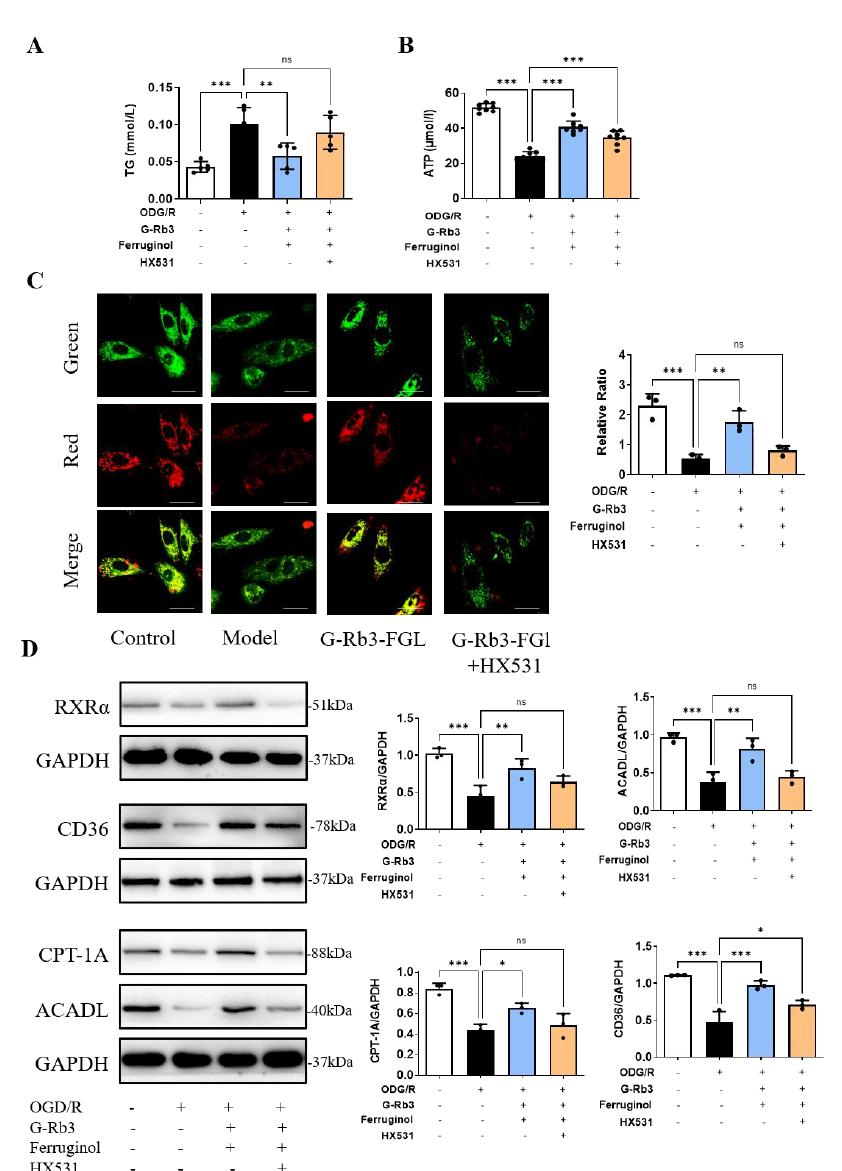
Figure 4. G-Rb3-FGL promoted fatty acid oxidization in vitro. ( A , B ) G-Rb3-FGL treatment changed the level of TG ( N = 5 per group) and ATP ( N = 8 per group) in H9C2 cells subjected to OGD/R. ( C ) JC-1 staining of four groups ( × 100), red fluorescence of the J-aggregates and green fluorescence of the J-monomeric. ( D ) The expression level of fatty acid oxidization-associated proteins in H9C2 cells quantified and shown as relative protein expression levels after normalization to GAPDH ( N = 3 per group). All data were presented as means ± SD from independent experiments performed in triplicate. ns No statistical significance, * p < 0.05, ** p < 0.01, *** p < 0.001 vs. model